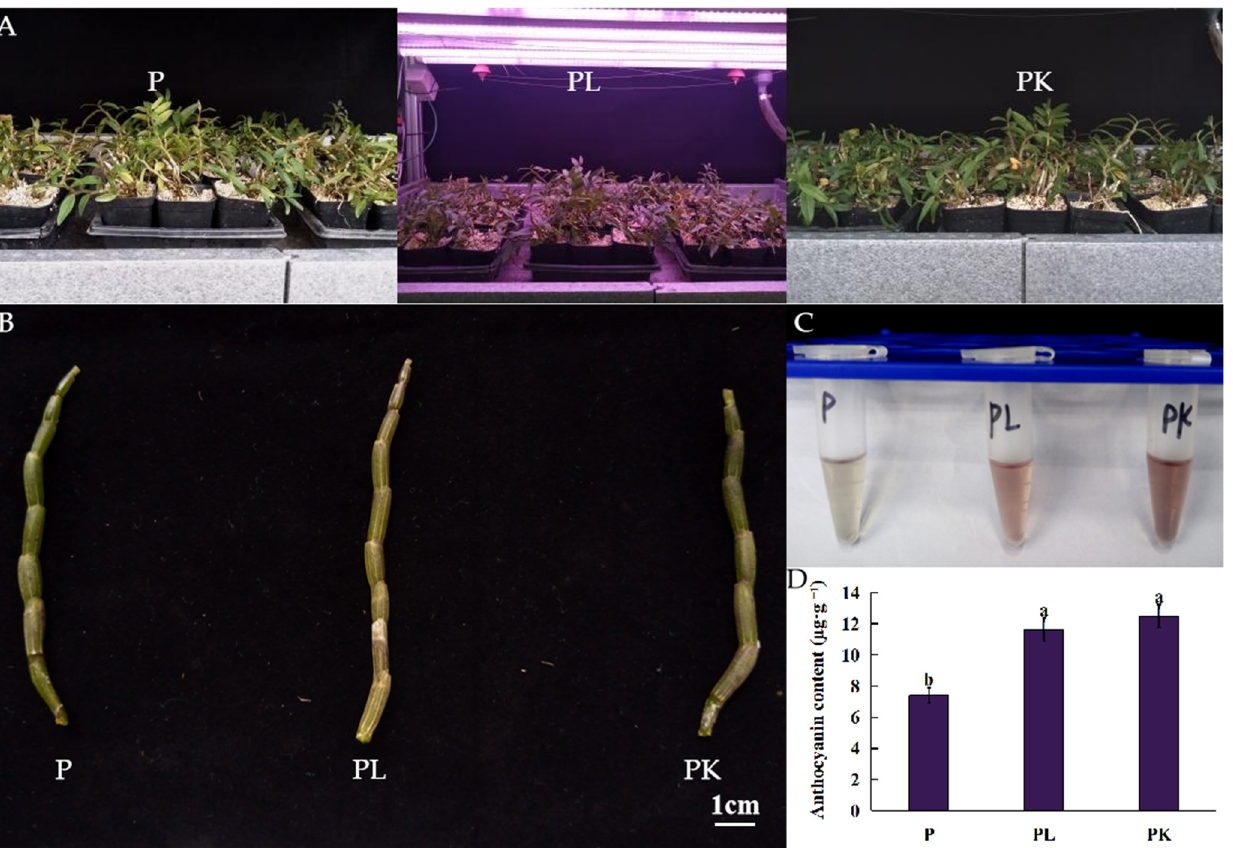
Figure 1. The changes in phenotype and anthocyanin content of D. officinale post light- or K-treatment. ( A ) The pseudobulbs (P) under natural light were used as the control, light-treated pseudobulbs (PL) were treated with red and blue light in 5:1, and K-treated pseudobulbs (PK) were treated with 3 mM KCl. ( B ) The phenotype of D. officinale pseudobulbs. ( C ) Anthocyanin extracted from pseudobulb of D. officinale . ( D ) The content of anthocyanins in D. officinale pseudobulbs post light- or K-treatment. The different letters represent significant difference at p < 0.05.